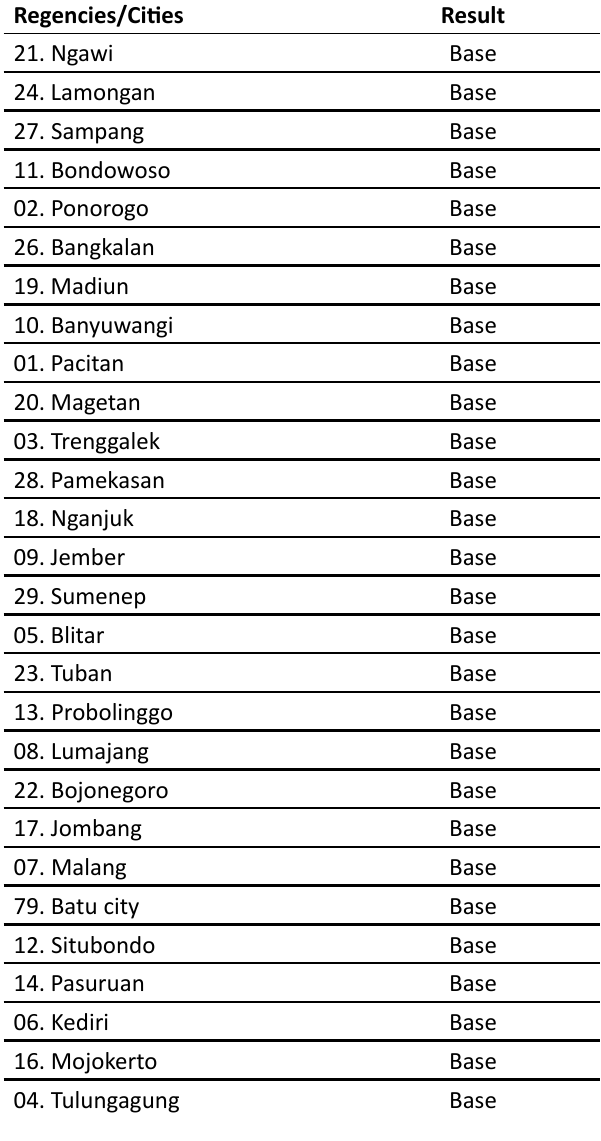
Table 4: Base and Non Base areas in Rice Sector by